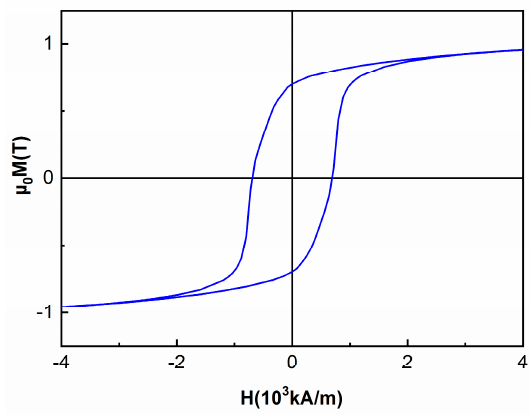
Figure 8. 300 K hysteresis loop for the annealed sample.